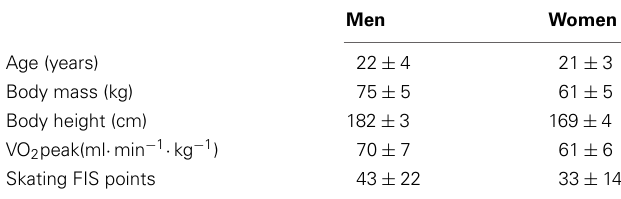
Table 1 | Anthropometric and performance characteristics of 31 males and 19 females elite cross-country skiers (mean ±